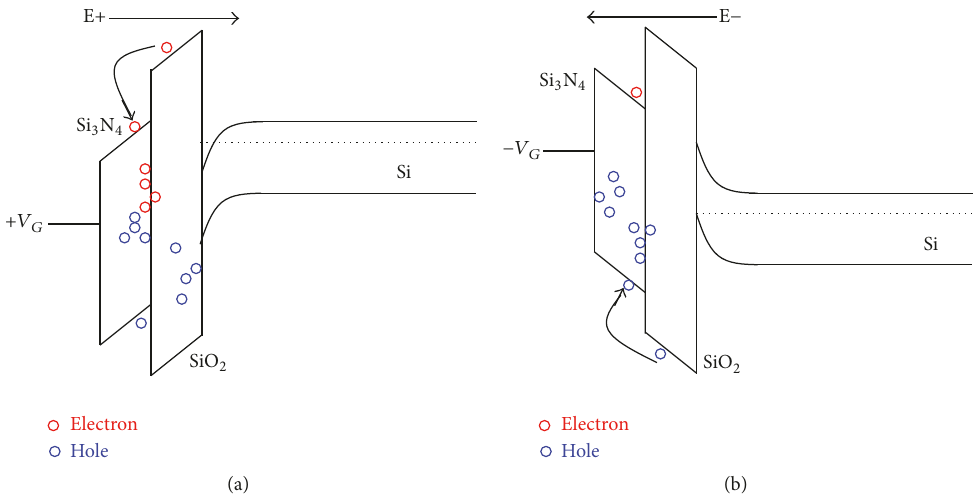
Figure 5: Schematic illustration of charge trapping during biased irradiation at both (a) positive and (b) negative gate